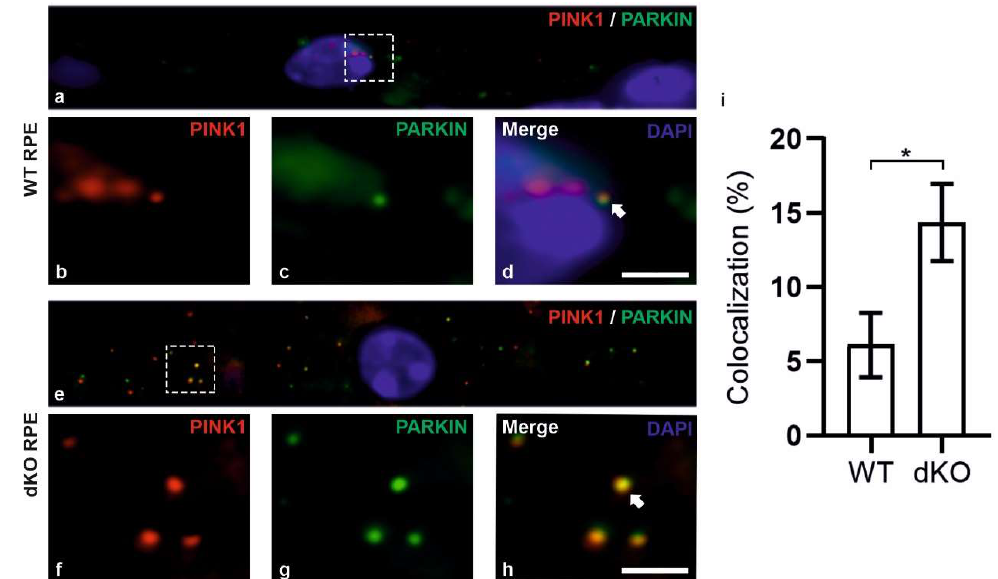
Figure 3 . Confocal microscopy analysis of the mitophagy initiation in the RPE cells by staining PINK1 and PARKIN. One-year-old WT and dKO mice focusing on the RPE cells in the vicinity of the optic nerve ( a , e ). PINK1 ( b , red) and PARKIN ( c , green) were double-stained and the merged image ( d ) was used to count the colocalized puncta from WT. Similarly, in dKO PINK1 ( f , red) and PARKIN ( g , green) were double-stained, and the merged image ( h ) was used to count the colocalized puncta. In dKO, we observed a ~7% decrease in the total number of puncta; however, the number of colocalizations was increased by ~118% ( i ). Scale = 5 µm. *p = 0.01.